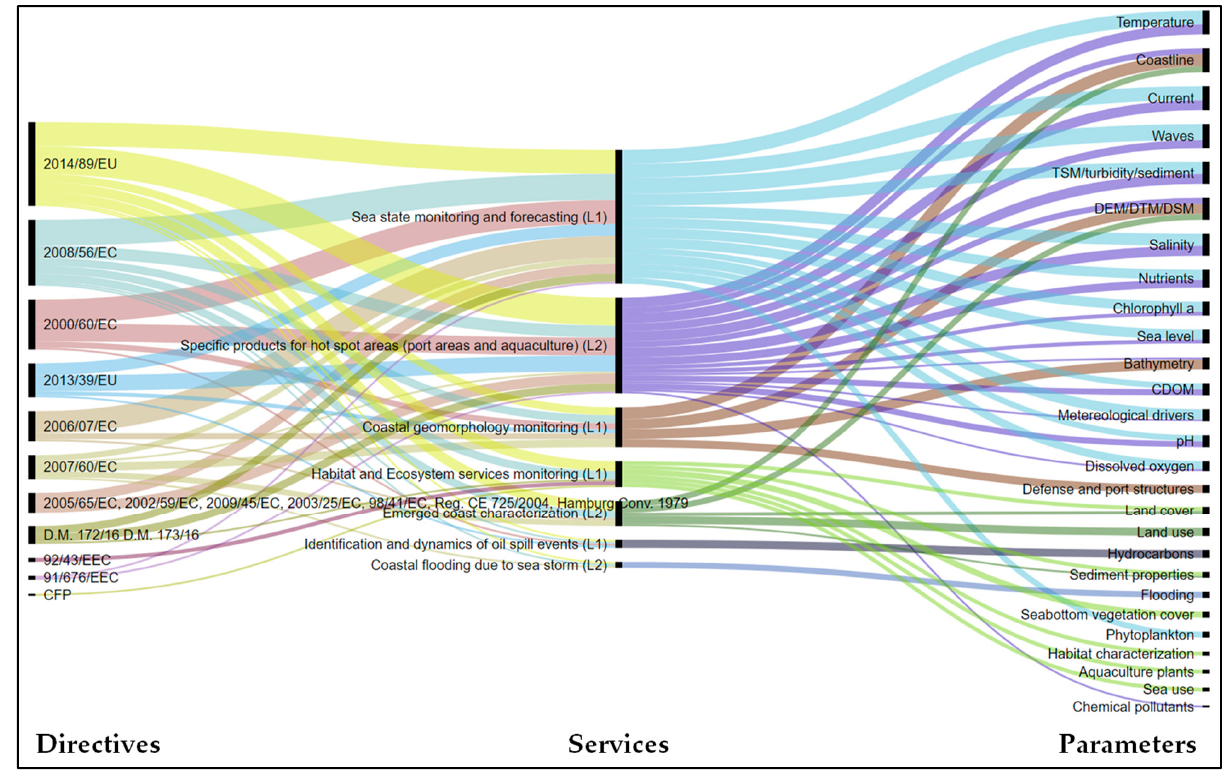
Figure 6. Sankey diagram connecting the European Directives (on the left ), the identified national operational services (in the middle ) and the provided parameters (on the right ).